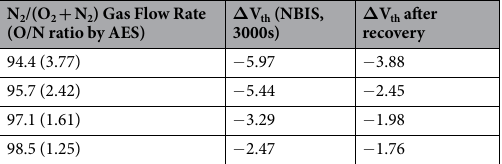
Δ V th (NBIS, 3000s)